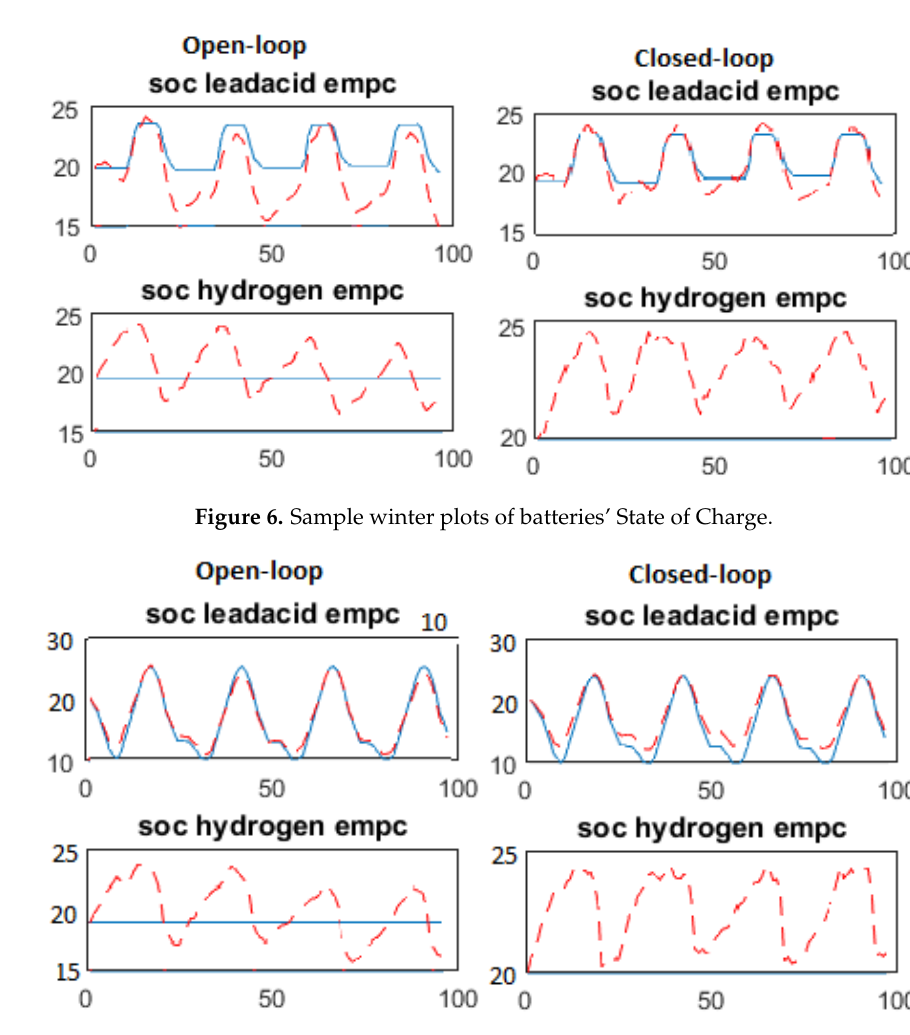
Figure 7. Sample summer plots of batteries’ State of